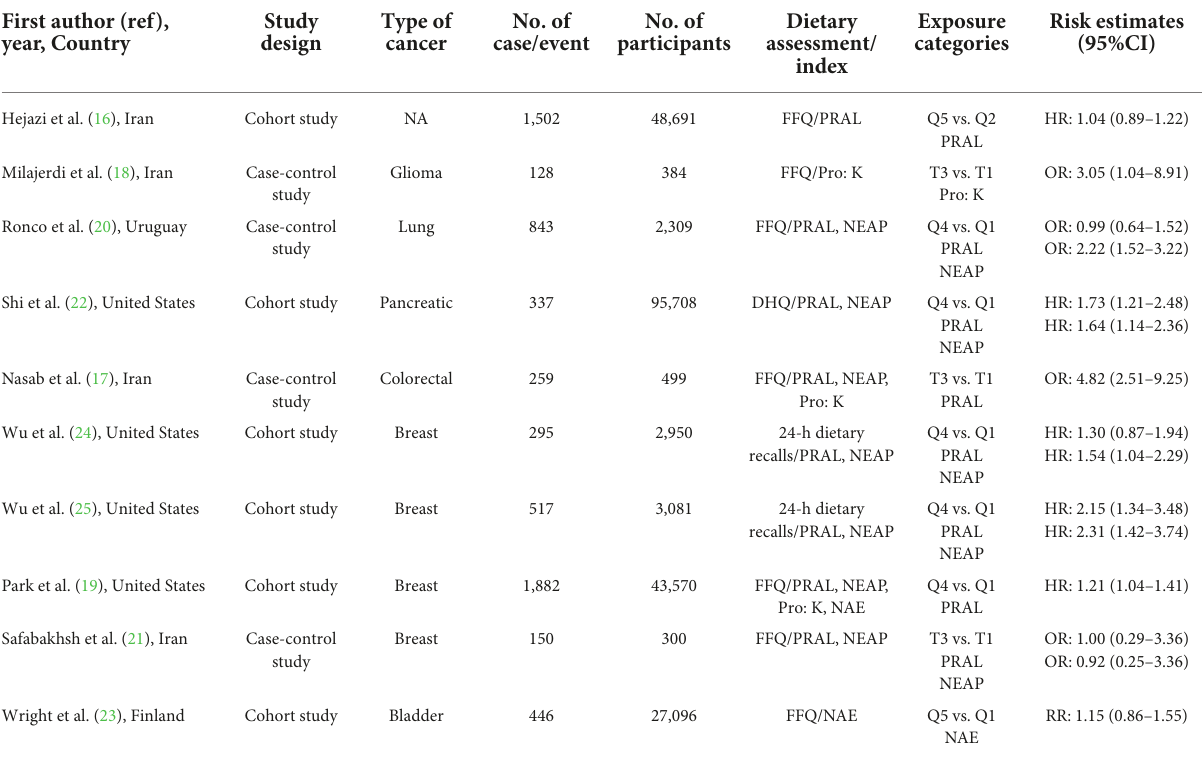
TABLE 1 Characteristics of studies included in the systematic review and